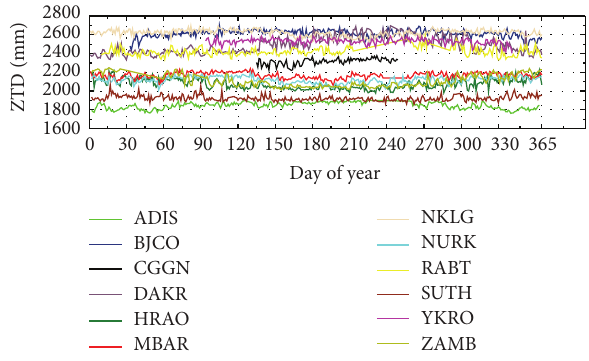
Figure 3: Daily variation of ZTD estimates over Africa in 2013 (days